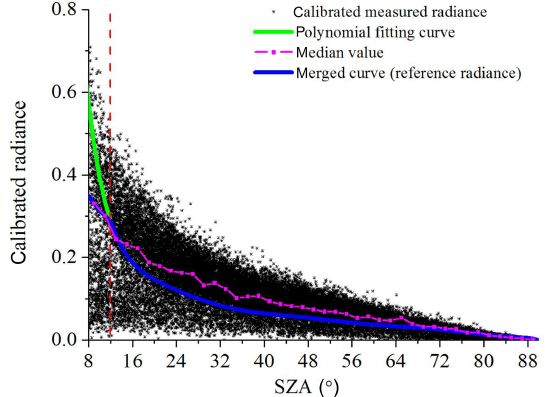
Figure 5. Calibrated measured zenith radiances at 380nm (black points) extracted from all measurements for zenith view in the whole period. The blue curve represents a merged clear sky ref- erence values over the whole SZA range (8–90 ◦ ): above 81 ◦ it is based on radiative simulation results; between 12 and 81 ◦ it rep- resents a polynomial fit to the clear sky measurements shown in Fig. 8b; below 12 ◦ it is determined by calculating the median value of the measured radiance (see text). The green curve represents the extension of the polynomial fit to SZA<12 ◦ . The magenta curve represents the median values of the measured radiance. The red dashed line presents the SZA of 12 ◦